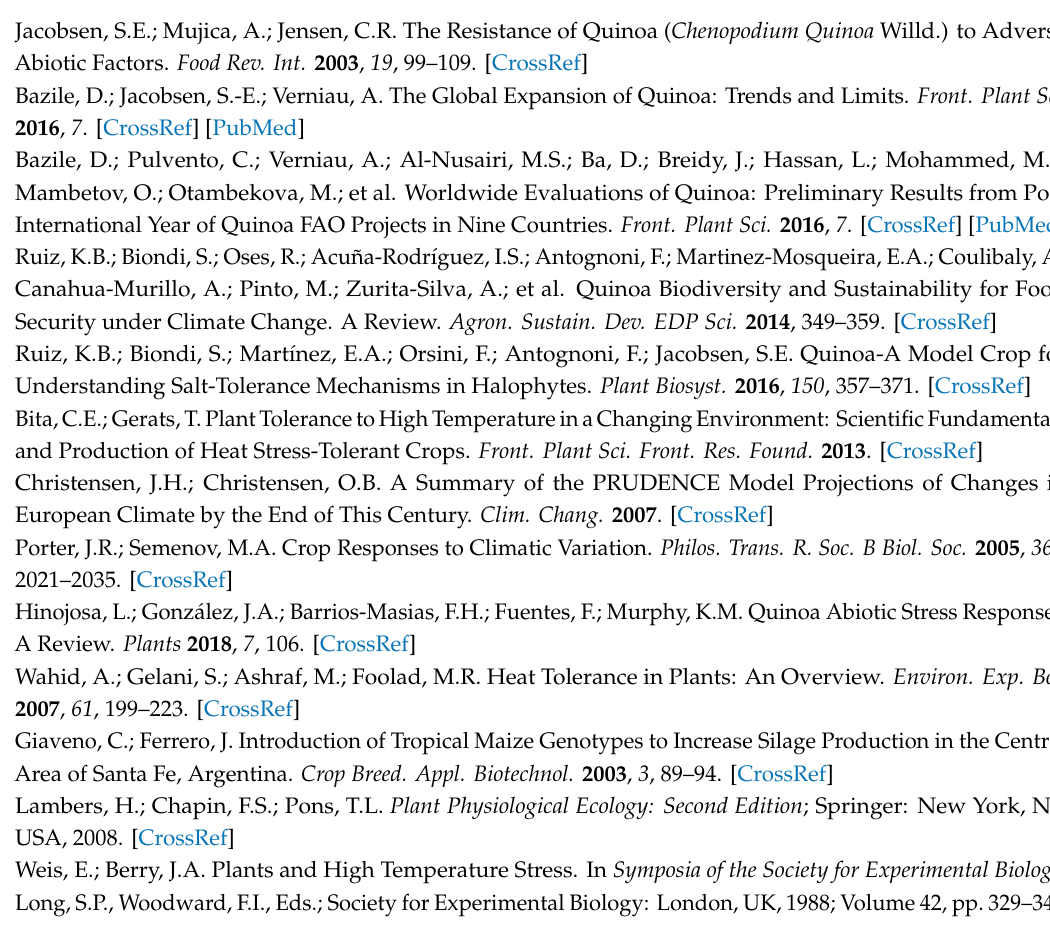
Figure S1: Relative chlorophyll by day of 10 quinoa genotypes exposed to a four-day heat treatment ( A ) (45 ◦ C / 30 ◦ C) and control treatment ( B ) (20 ◦ C / 14 ◦ C); day and night, respectively. Each point represents a mean relative chlorophyll content for each genotype ( n = 5–9). The fitted lines indicate the slope calculated from the linear regression model where average relative chlorophyll is a response to